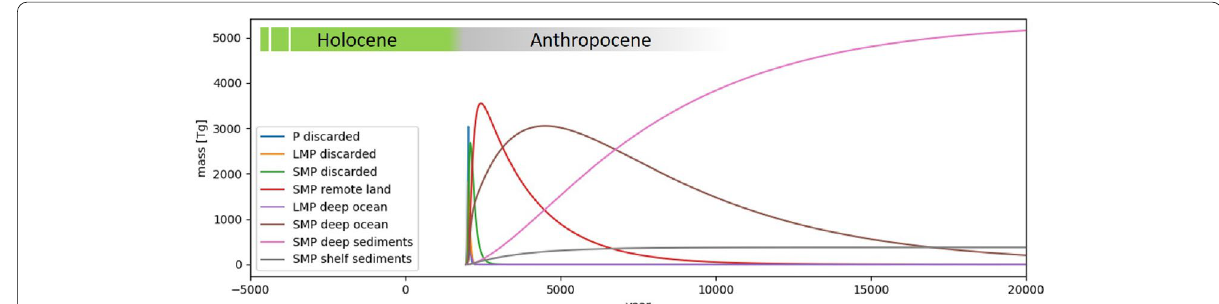
Fig. 4 Plastics dispersal through Earth surface reservoirs from 1950 to the year 20,000 CE, following a halt on production and discard in 2025. This is the same model scenario that is shown in Fig. 3, and illustrates over what timescales discarded microplastic (P, > 5 mm), large microplastic (LMP) and small microplastic (SMP, < 0.3 mm) potentially disperse via rivers and air into oceans, remote terrestrial surfaces, and marine sediments. P and LMP disappear in all transitory reservoirs within 100 and 200 years due to fragmentation at an annual rate of 3%. The prolonged dispersal of SMP in all reservoirs is driven by cyclical marine emissions to air, deposition to terrestrial surfaces, runoff to surface oceans, and re-emission to air. Only a small fraction of SMP sinks to shelf sediments and to the deep ocean, followed by slow sedimentation to deep ocean sediments